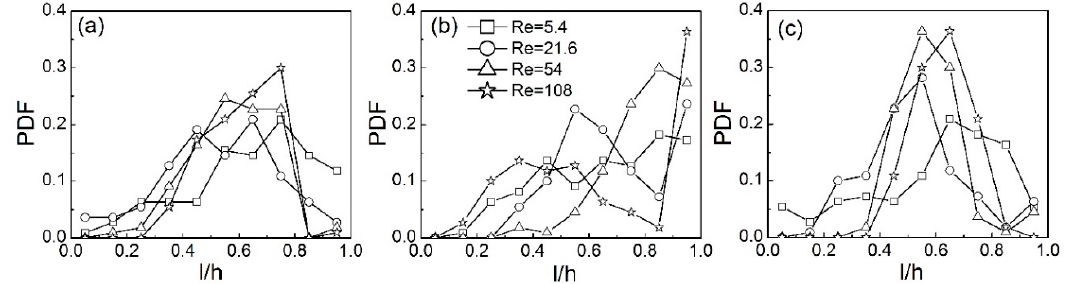
Figure 21. Lateral probability distribution functions for different cases, ( a ) non-adhesive particles, ( b ) adhesive particles with γ = 0.075, and ( c ) adhesive particles with γ = 0.0075.